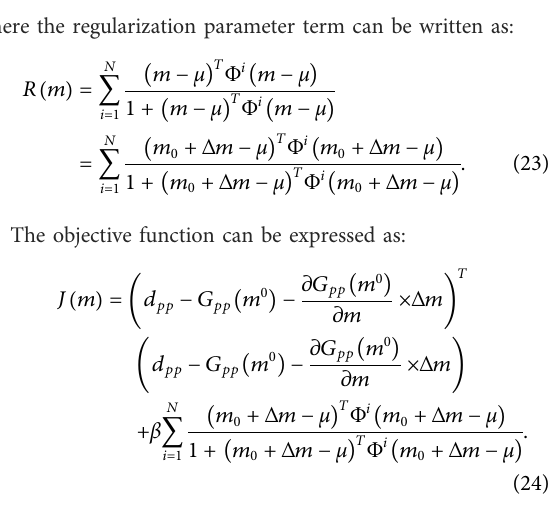
FIGURE 3 Synthetic pre-stack angle gathers. The incident angle is 7 ° , 12 ° , 17 ° , ... , 47 °